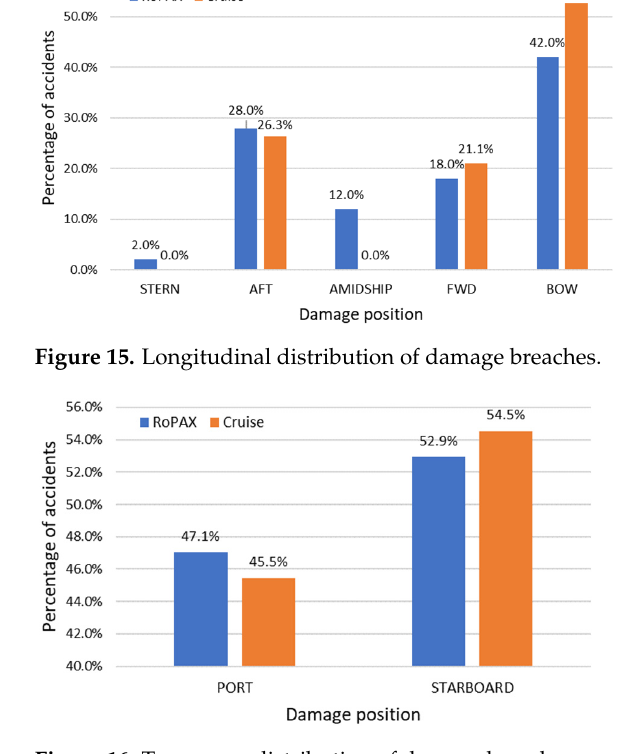
Figure 17 . Vertical distribution of damage breaches . The statistical characteristics of damage parameters (length and width) are analysed based on the best-fit probability distribution function (PDF). The goodness-of-fit (GOF) method, using the Kolmogorov–Smirnov (K–S) tests combined with probability plots for a 95% confidence interval, is used to verify the selected PDF compatibility. The most well- known PDFs were chosen based on their popularity and relevance. The selected PDF is further confirmed using the lowest test statistics, which are the difference between the data sample and the fitted empirical CDF. Based on the results of the statistical analysis,